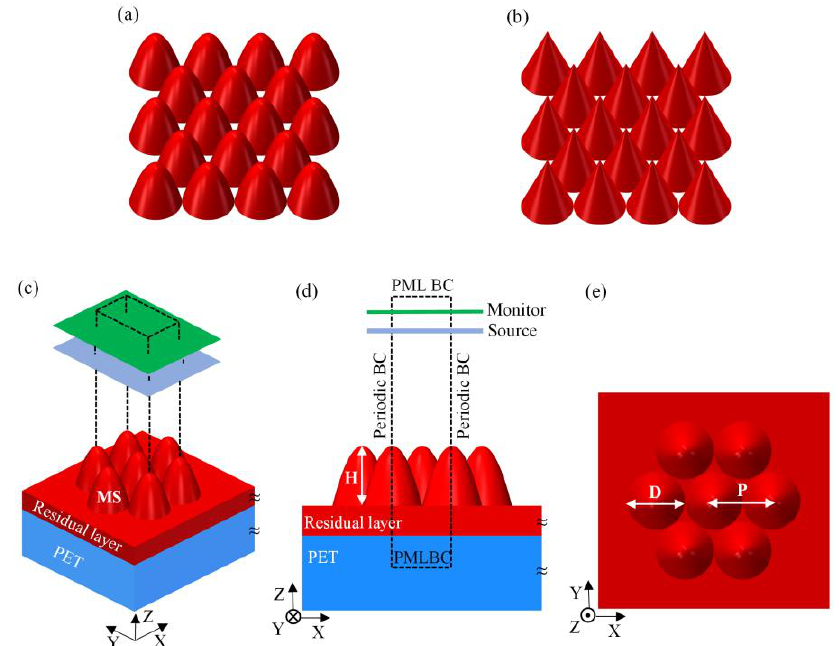
Figure 1. Schematic diagram of 3D physical model and simulation model: ( a ) parabola-shaped moth-eye structure (PSMS) array, ( b ) cone-shaped moth-eye structure (CSMS) array, and ( c – e ) parameter setting of simulation unit with the hexagonal close-packed arrangement.